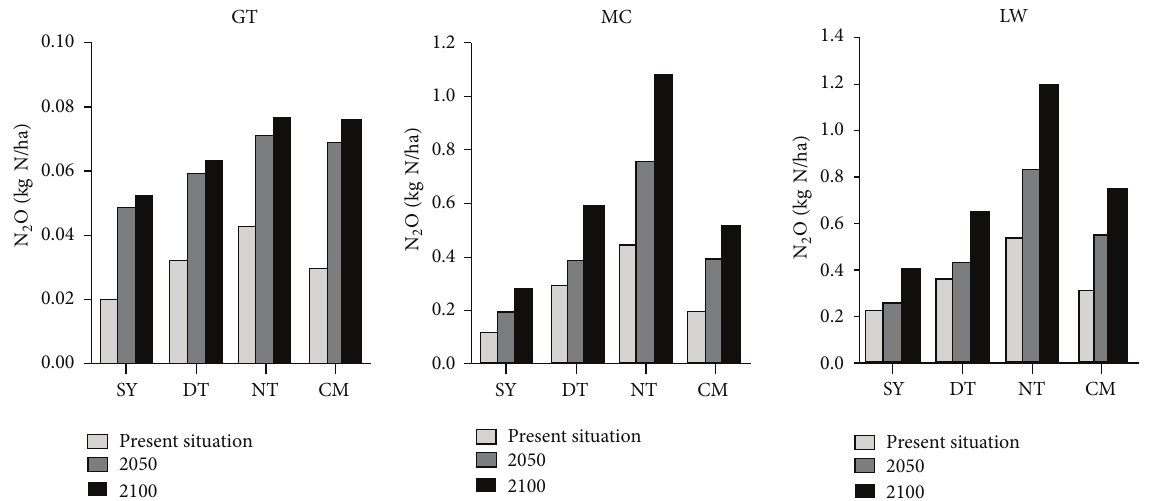
Figure 5: Comparison of present (average N 2 O emission flux of 80s and 00s) and future N 2 O emission flux of different vegetation zones at different